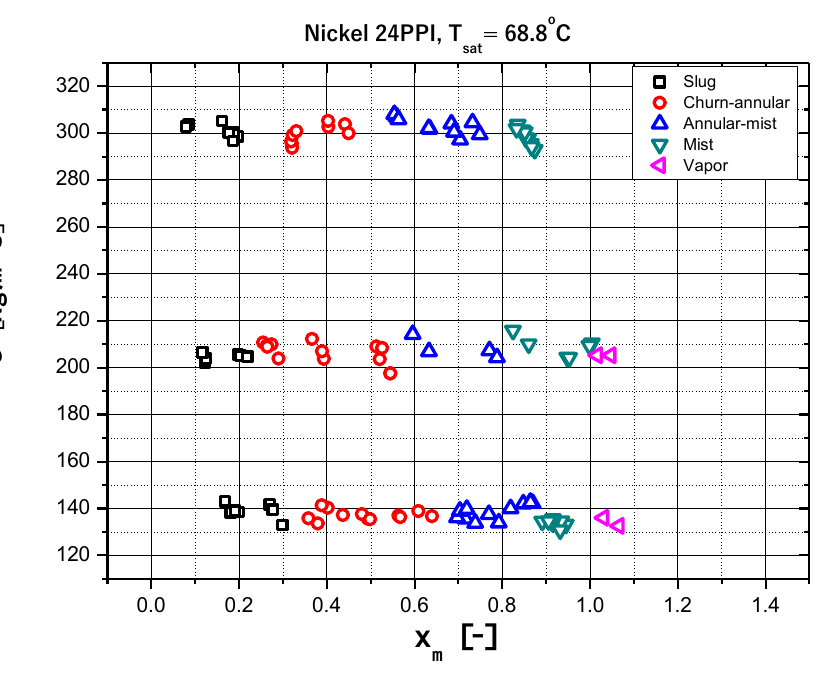
Figure 10. Flow pattern maps based on the vapor quality and mass flux in 24-PPI nickel porous media filled channel at T sat = 68.8 °C.